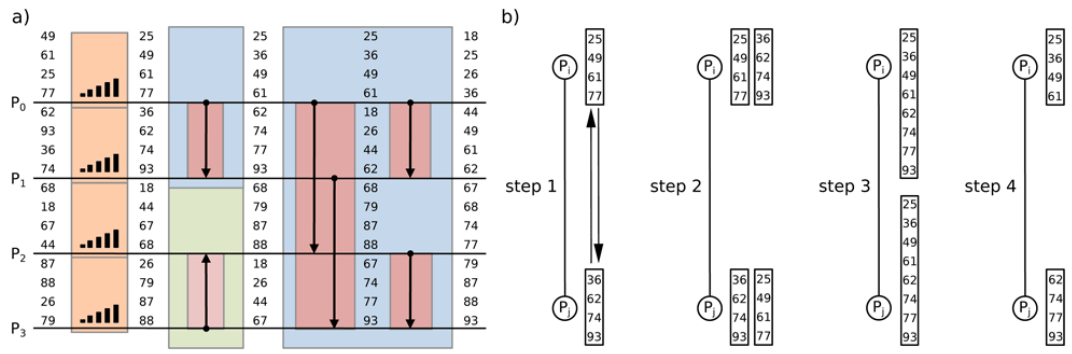
Figure 4. Parallel bitonic sort of 16 elements with four processors. ( a ) Each horizontal line represents an input of elements attached to a processor. Each processor first locally sorts its list of 4 elements, then, the parallel sort performs three steps of compare-split operations over the bitonic sorting network. ( b ) During the compare-split operation, each pair of processors first exchanges their information: each processor sends its block to the other process, then it merges the two sorted blocks into one list and stores only the appropriate half of the merged block to be used in the next step (adapted from Kim et al. (2001) & Grama et al.